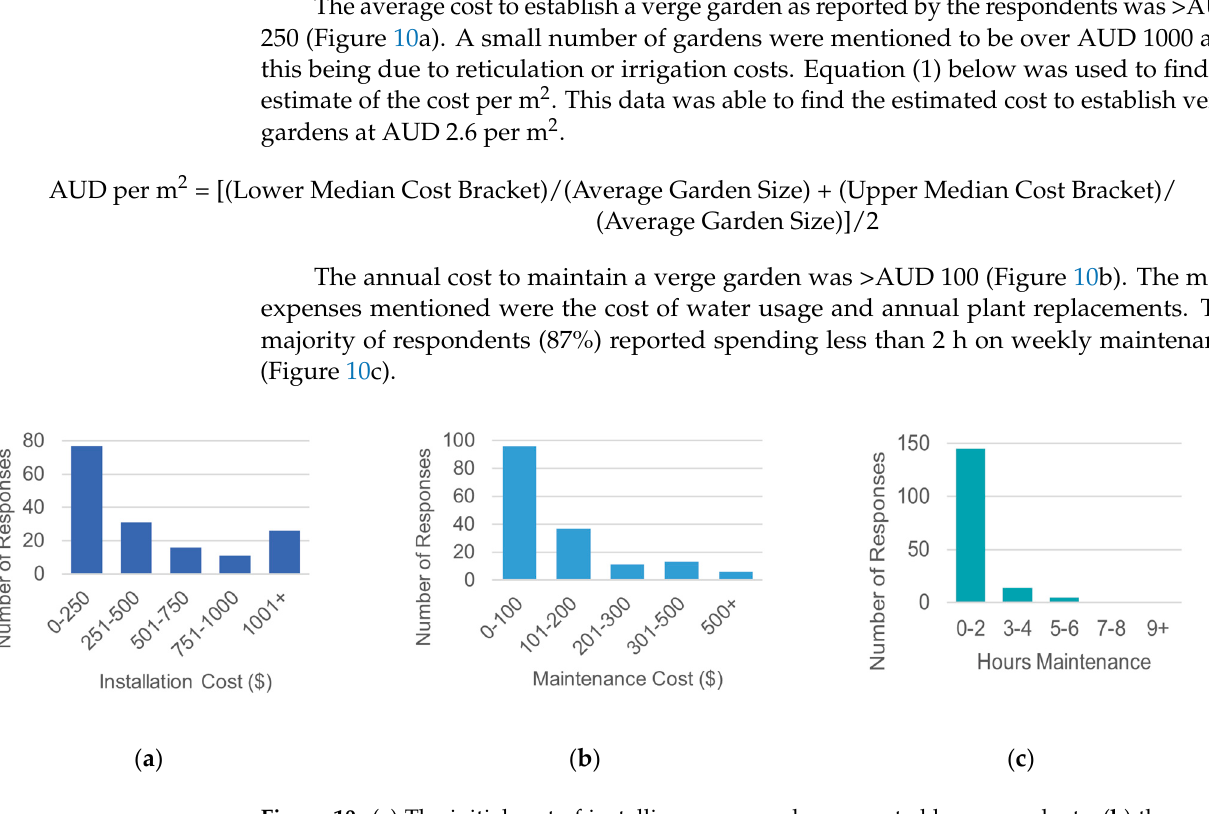
Figure 9. ( a ) The number of times a motivation was mentioned by the respondents (multiple responses counted, total responses = 615); ( b ) types of values added to the street or local environment by the verge gardens.